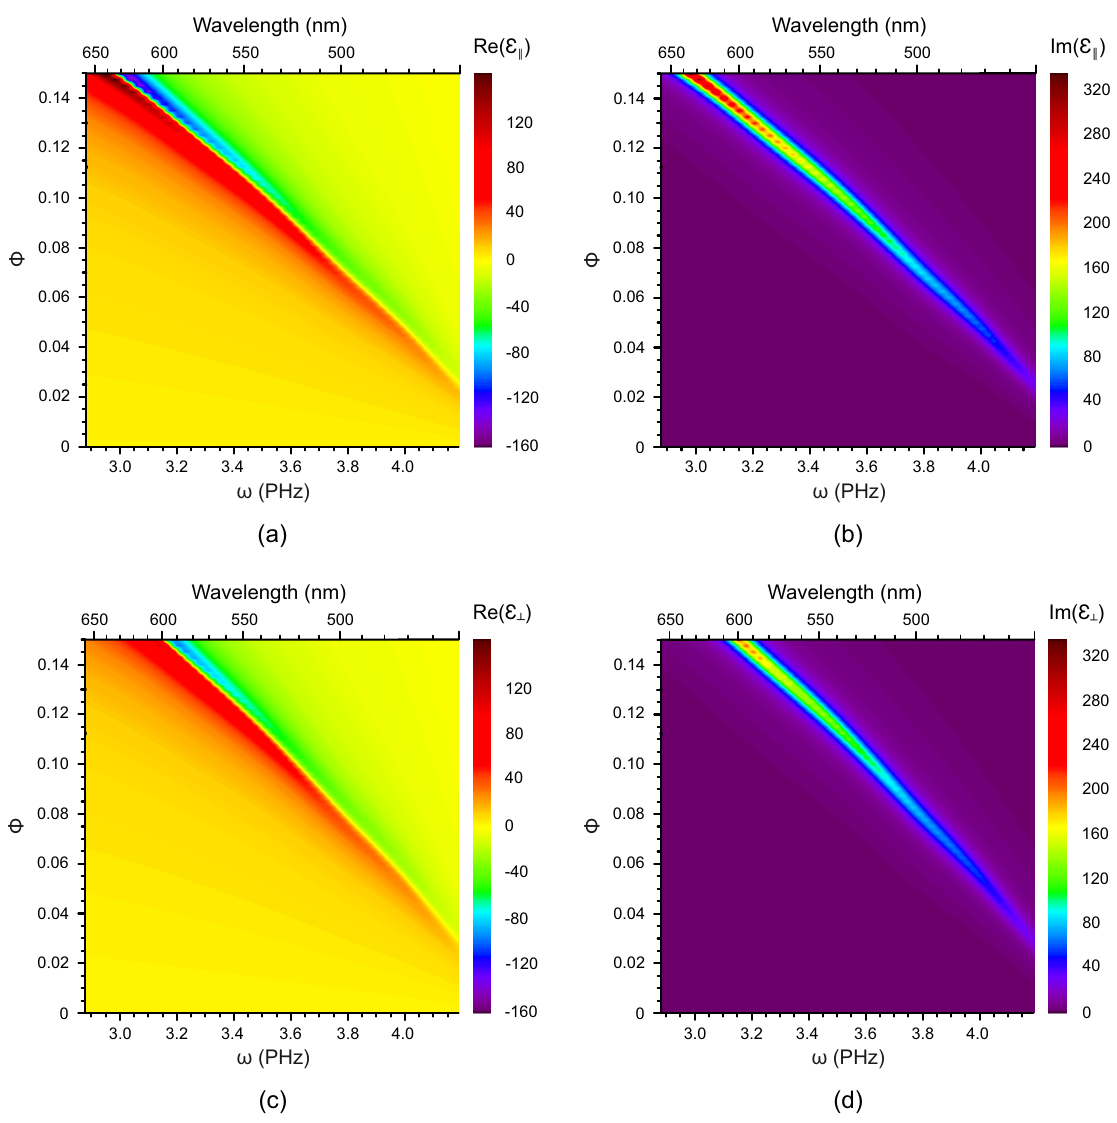
Figure 3. The dependence of Re ( ε (cid:107) ) ( a ), Im ( ε (cid:107) ) ( b ), Re ( ε ⊥ ) ( c ) and Im ( ε ⊥ ) ( d ) of the nematic nanocomposite (host 5 CB plus AgNPs) on the volume fraction of AgNPs φ and cyclic frequency ω